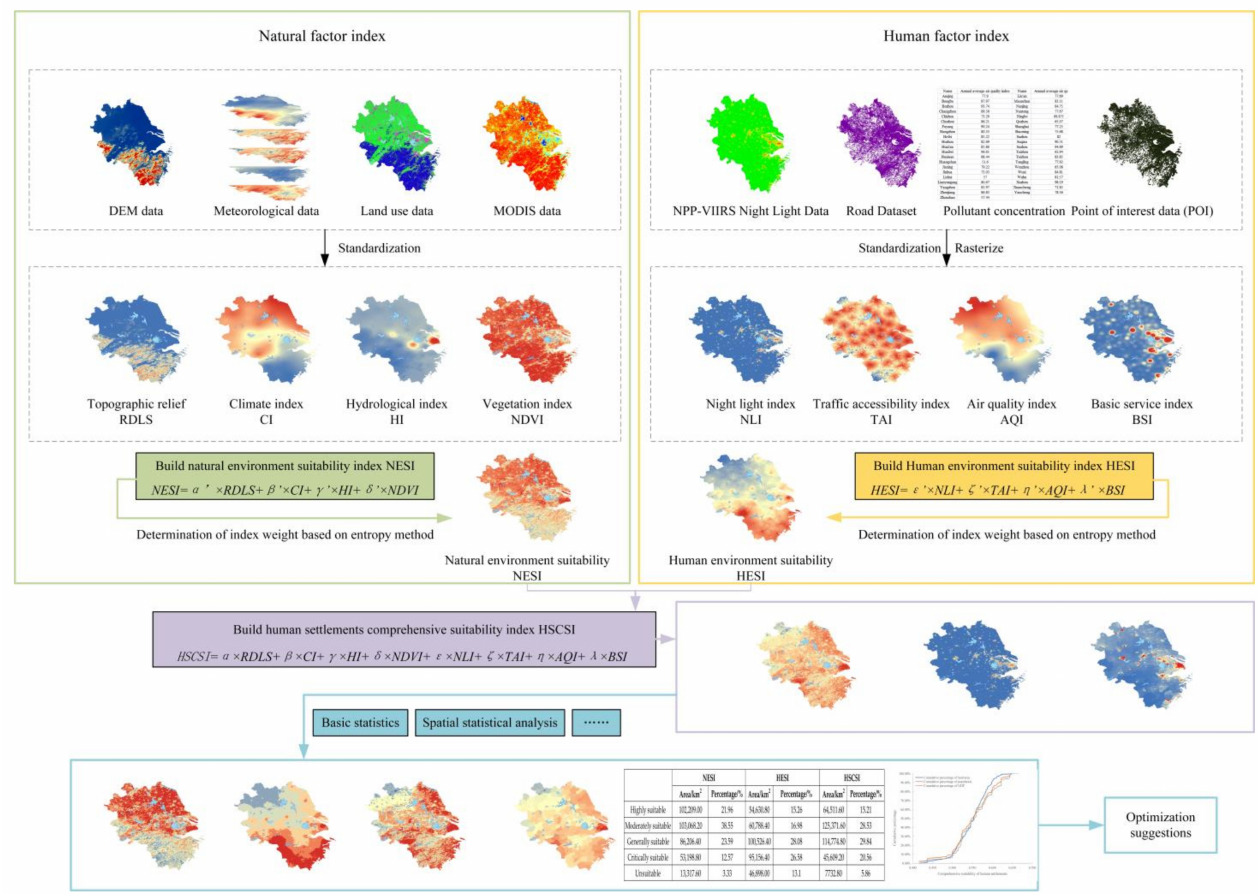
Figure 2. Evaluation framework of HSCSI in the